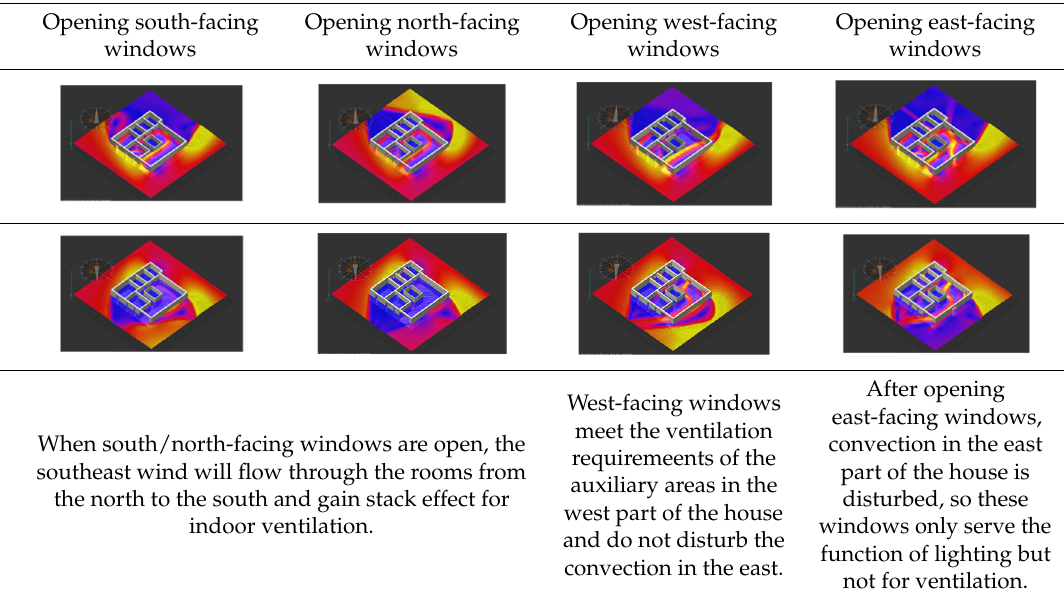
Table 4. Natural ventilation simulation.